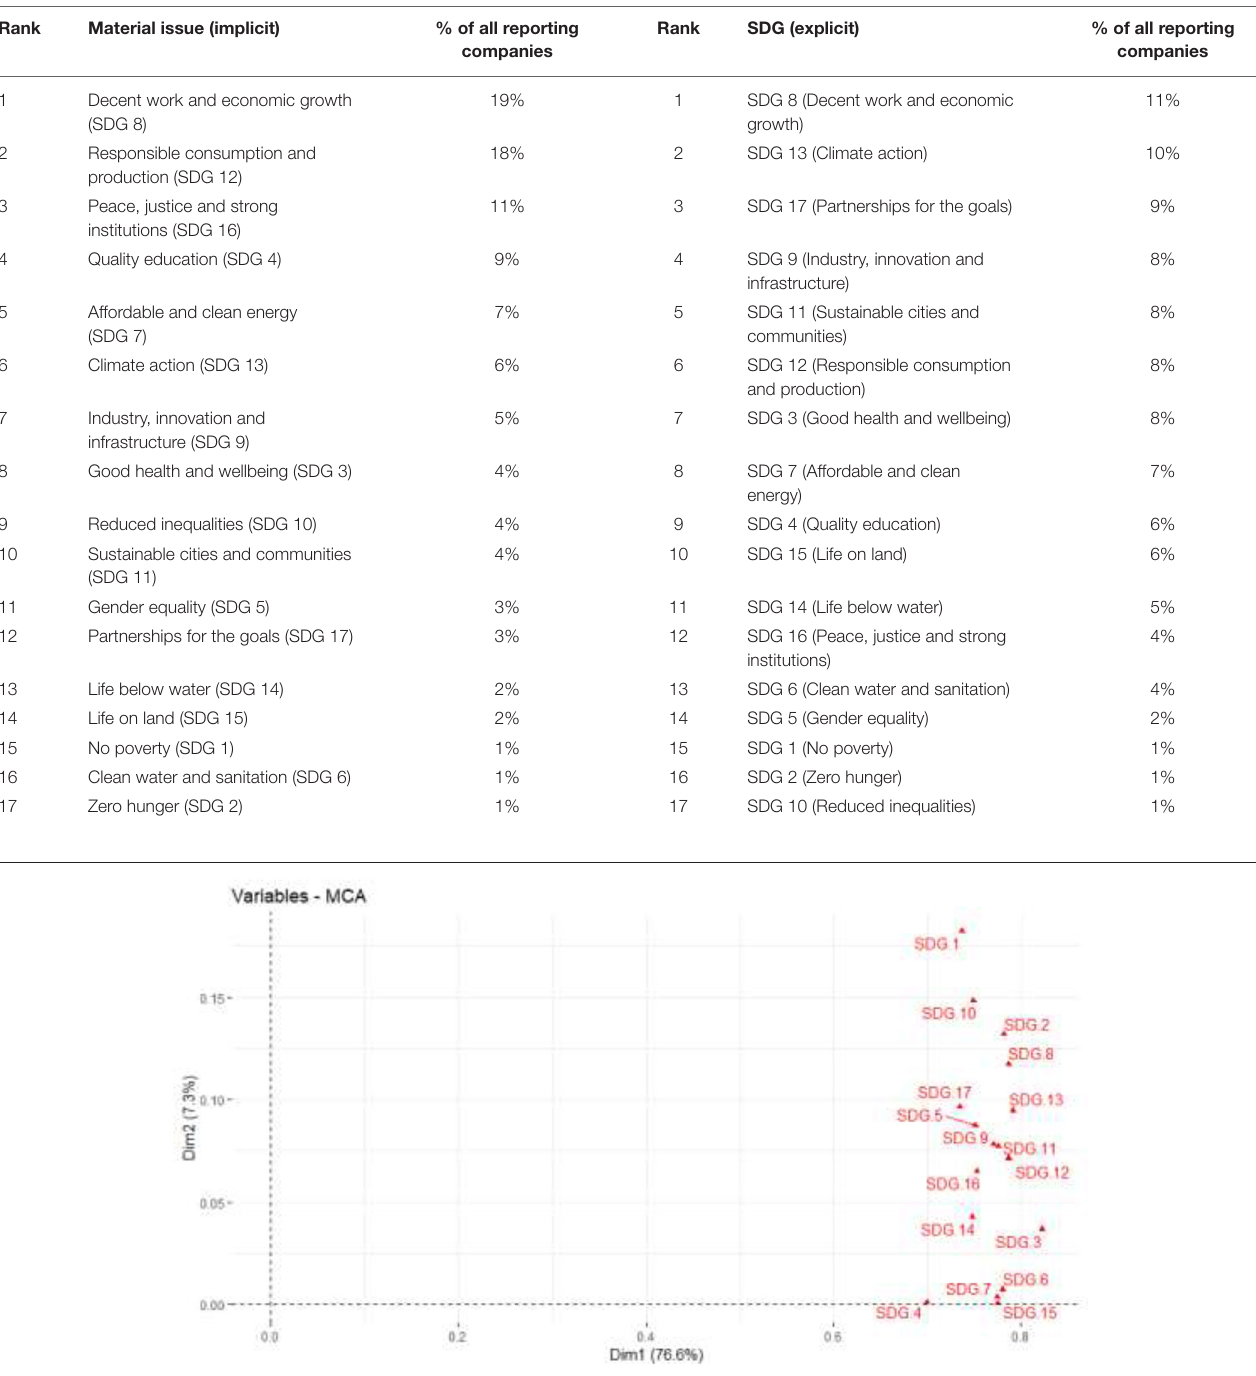
FIGURE 1 | Factor analysis explicit SDG reporting